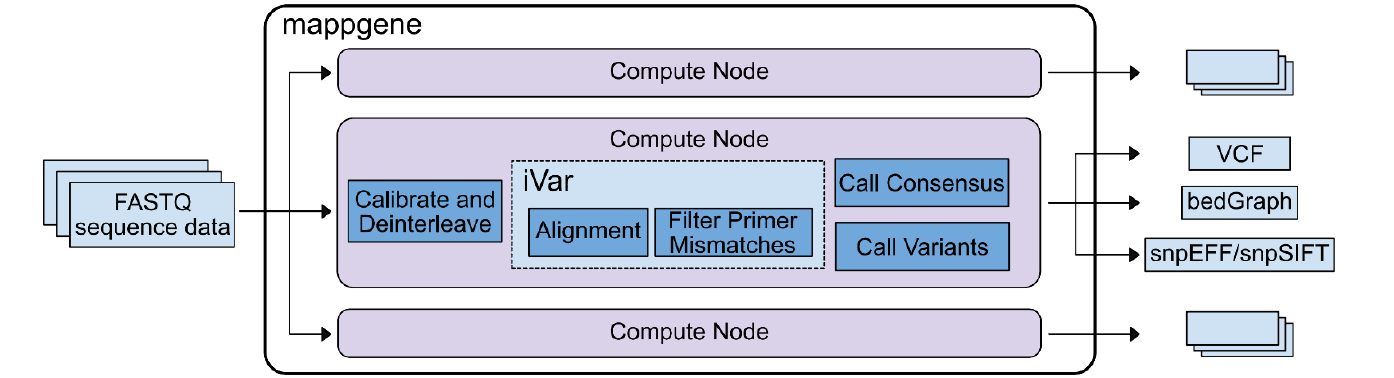
Figure 1. Mappgene pipeline overview . The center box shows the mappgene pipeline workflow, and the other 2 computer node boxes above and below the mappgene node signify that mappgene can be run on parallel nodes to process large datasets more rapidly. Note, mappgene uses both iVar and LoFreq to call variants.